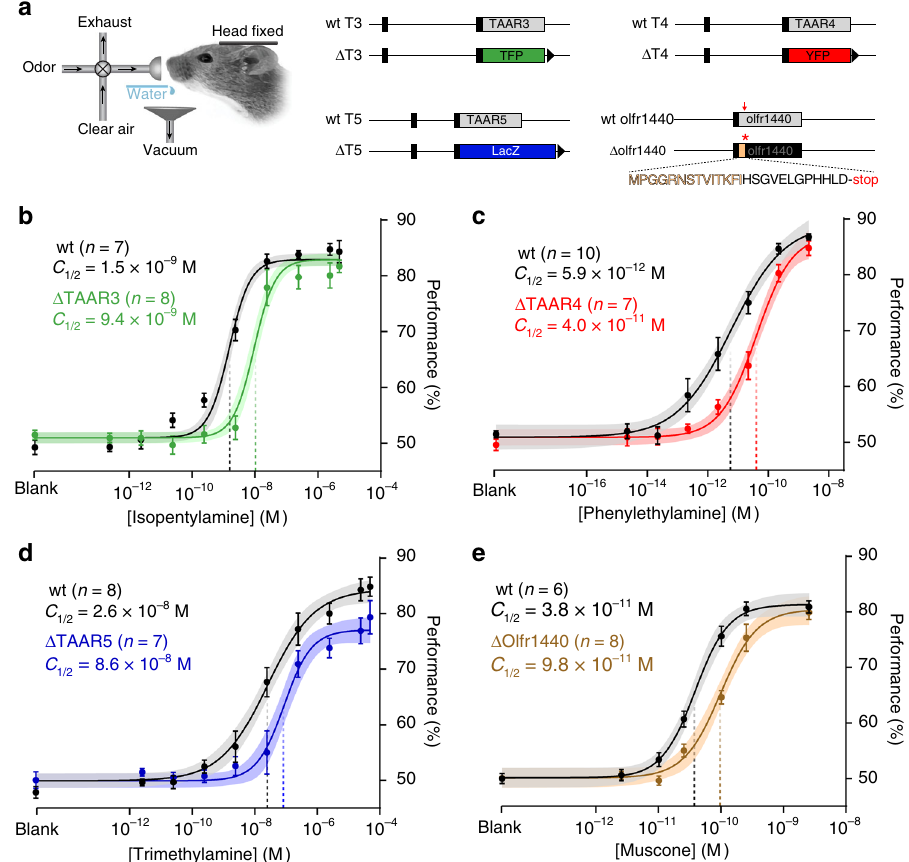
Fig. 3 Deletion of single olfactory receptor genes causes detection de fi cits. a Head- fi xed thresholding was performed on mice harboring different gene targeted alleles (right). Three coding sequence replacements at the taar3 , taar4 , and taar5 loci are shown. Black boxes are non-coding regions. Receptor coding sequences (gray) were replaced with teal fl uorescent protein (TFP; green), β -galactosidase (LacZ; blue), and yellow fl uorescent protein, (YFP; red). The olfr1440 deletion was generated by CRISPR-based gene editing. Red arrow shows the position of targeted PAM site and frameshift. The truncated coding sequence is shown (native sequence in tan). LoxP sites are indicated by black triangles. b – e Psychometric curves for receptor deletion (colored) and wild-type littermate controls (black) for Δ TAAR3 (green) to isopentylamine ( b ), Δ TAAR4 (red) to phenylethylamine ( c ), Δ TAAR5 (blue) to trimethylamine ( d ), and Δ Olfr1440 (tan) to muscone ( e ). Data were fi tted using a Hill function. Behavioral sensitivity is de fi ned as the odor concentration at half-maximal behavioral performance ( C ½ ) during a head- fi xed Go/No-Go conditioned assay. Plots show mean + / − SE with a shaded 95% con fi dence interval. Isopentylamine: wt C ½ = 1.5×10 − 9 M (95% CI = 0.9 – 2.2× 10 − 9 M); Δ T3 C = 9.4×10 − 9 M (95% CI = 6.6 – 13.2×10 − 9 M). Phenylethylamine: wt C = 5.9×10 − 12 M (95% CI ½ ½